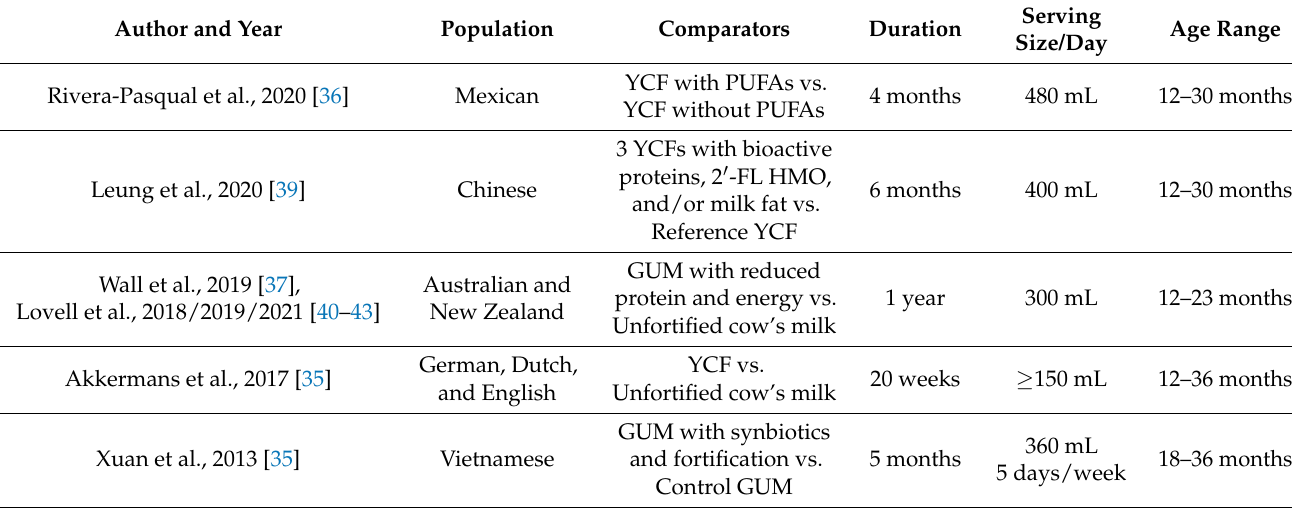
Table 2. Clinical Studies using Young Child Formulas